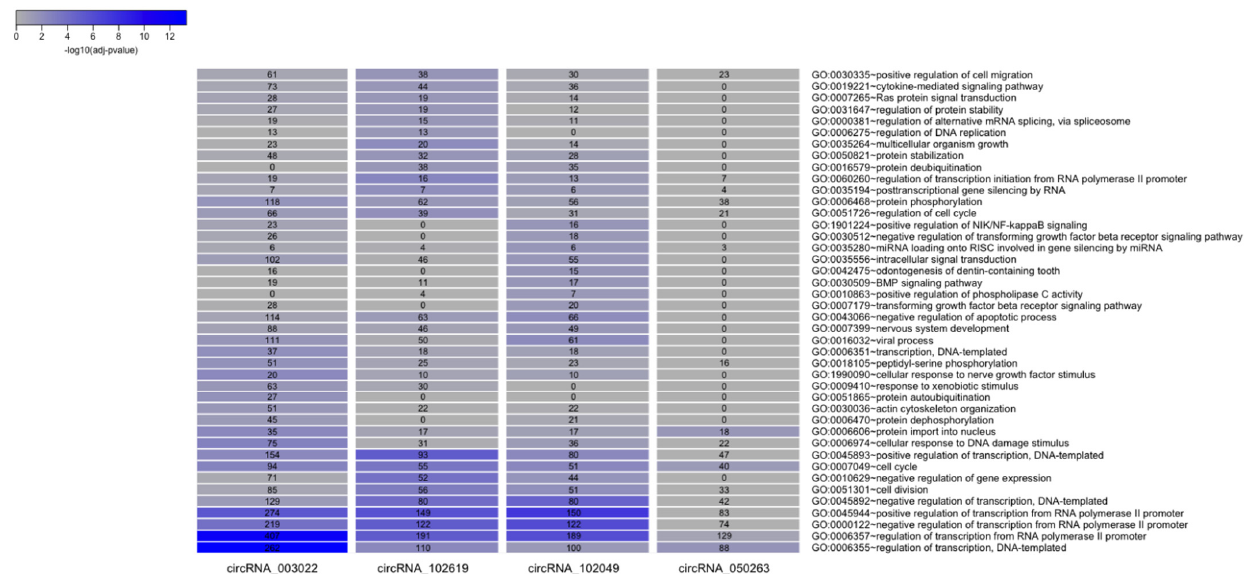
Figure 6. Comparison of Biological Processes GO terms over-represented in the groups of target proteins of each differentially expressed circRNA. All terms statistically enriched in at least one of the four groups (circRNA_003022, circRNA_102619, circRNA_102049, circRNA_050263) are reported in the heatmaps, with adjusted p -values plotted in blue-grey scale color, where blue indicates higher significant results.